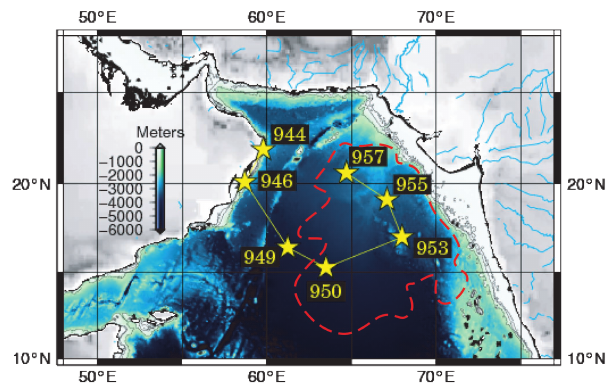
Fig. 1. Sampling stations (stars and station numbers) along cruise track (yellow) in the Arabian Sea in Sept/Oct 2007. The red dashed line marks the prominent secondary NO − maximum of ≥ 1µM in 2 the central-northeastern basin (Naqvi,